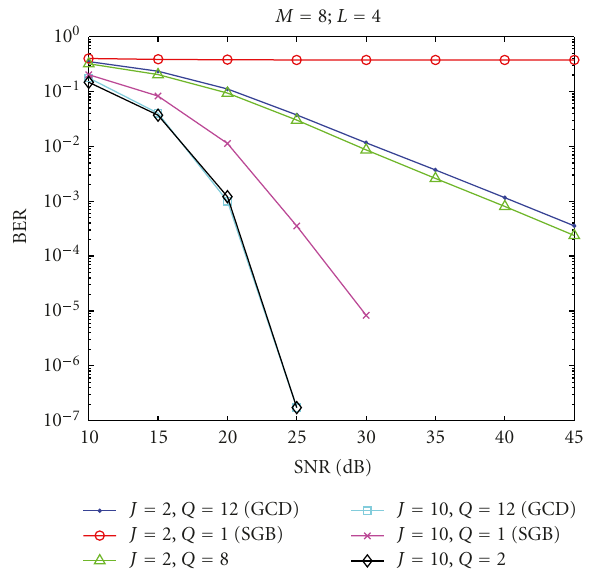
Figure 6: Bit error